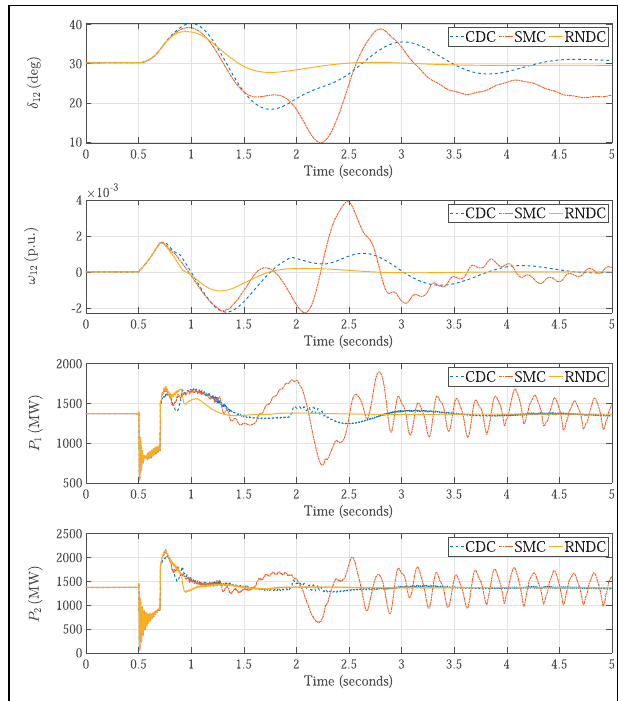
FIGURE 7 | Simulation results obtained under the condition of time